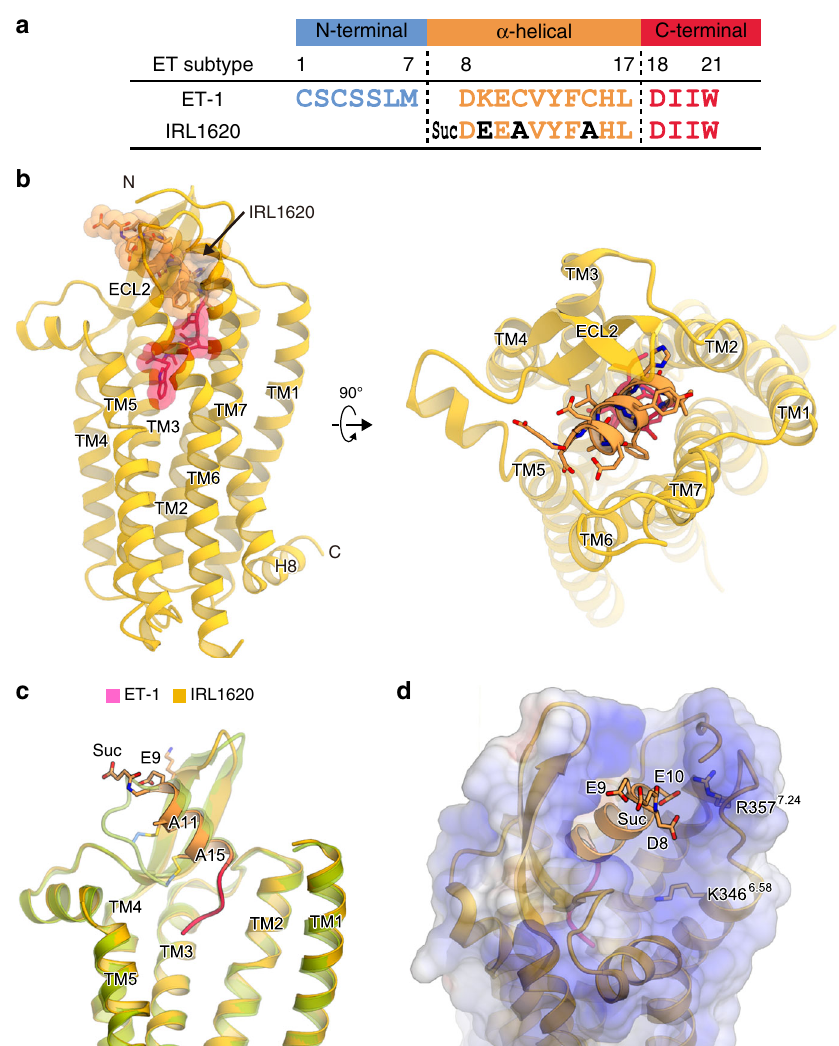
Fig. 3 ET B structure in complex with IRL1620. a Comparison of the amino acid sequences of ET-1 and IRL1620. b The overall structure of the IRL1620-bound ET B receptor. The receptor is shown as an orange ribbon model. IRL1620 is shown as a transparent surface representation and a ribbon model, with the α - helical and C-terminal regions coloured orange and deep pink, respectively. c Superimposition of the IRL1620- and ET-1-bound receptors viewed from the membrane plane, coloured orange and green, respectively. The ET B receptors and agonists are shown as ribbon models. The different residues between ET- 1 and IRL1620 are shown as sticks. d Electrostatic surfaces of the IRL1620-bound ET B structure. The negatively charged moieties on the N-terminal end of IRL1620 and the positively charged residues in the extracellular side of TMs 6 and 7 are shown as